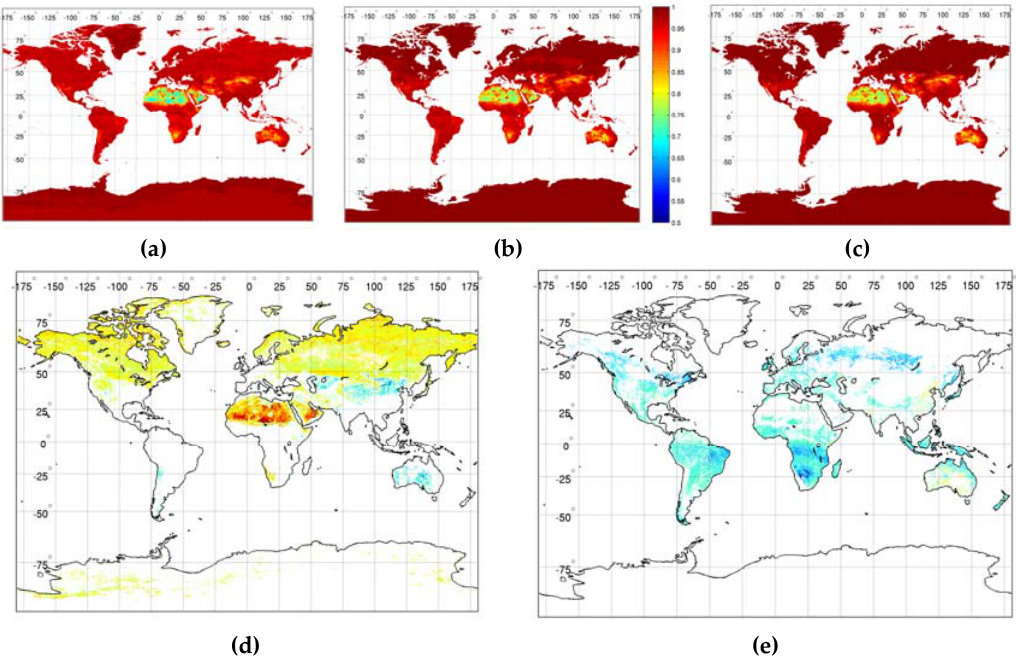
Figure 7. The UW BF ( a ), CAMEL ( b ) and the ASTER GEDv4 ( c ) emissivity at 8.6 µm for February 2004. The difference maps of the emissivity between CAMEL and UW BF database ( d ) and ASTER GED v4 ( e ) are also shown for February 2004.